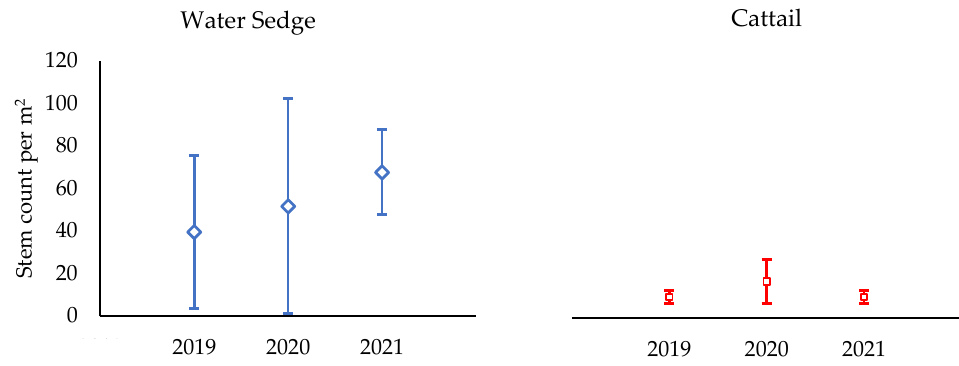
Figure 4. Mean stem counts for water sedge and cattail per 1 m 2 plot observed in the shallow cells of the Kearl Treatment Wetland in 2019–2021. Error bars represent standard deviations (n = 18) for each species, each year.